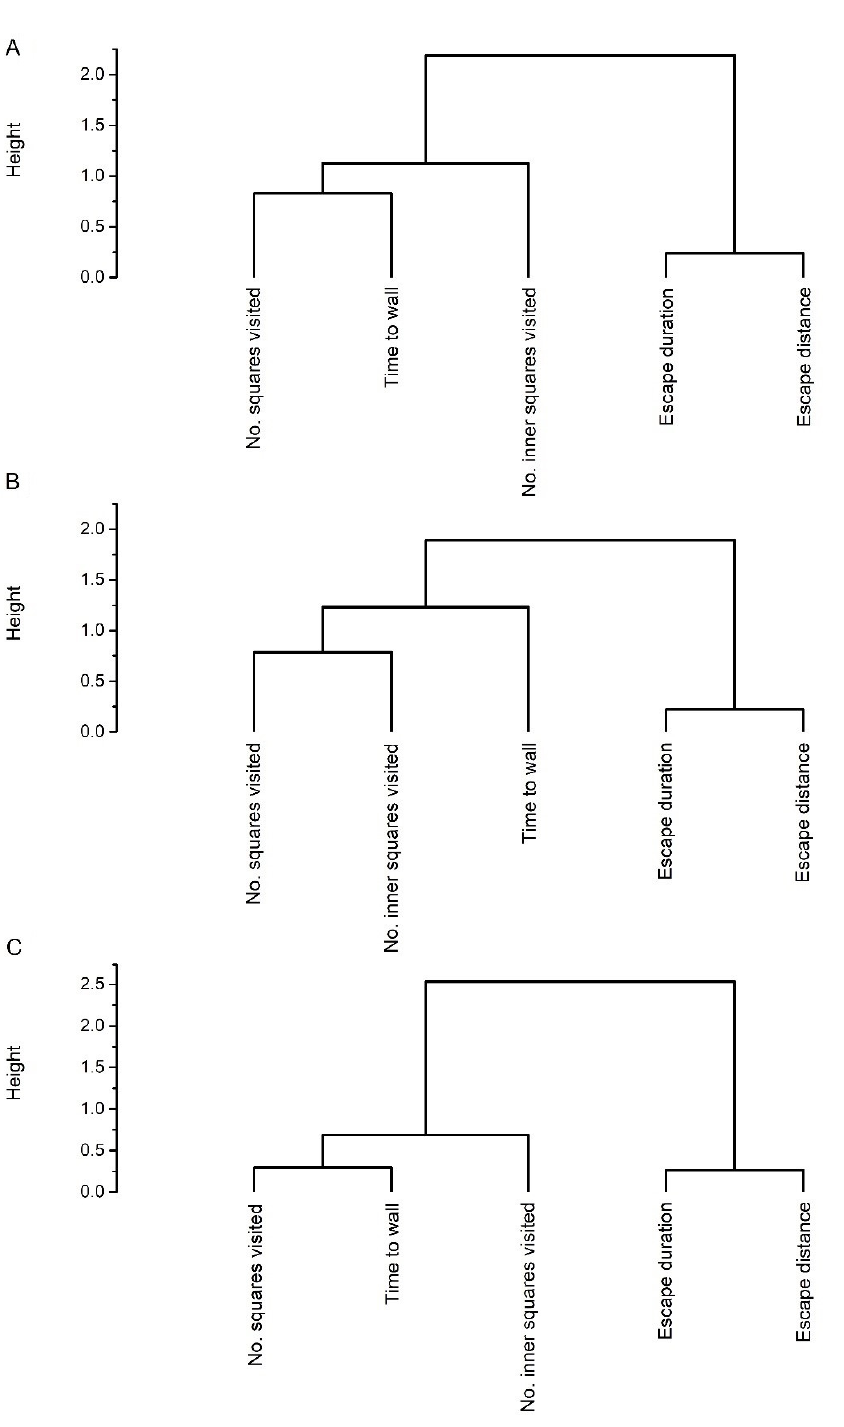
Figure 1. Grouping of the studied behavioral measures by agglomerative cluster analysis (agglomerative coefficient: 0.70, 0.66, and 0.86, respectively) for Abemus chloropterus ( A ), Ocypus nitens ( B ), and Platydracus fulvipes ( C ).